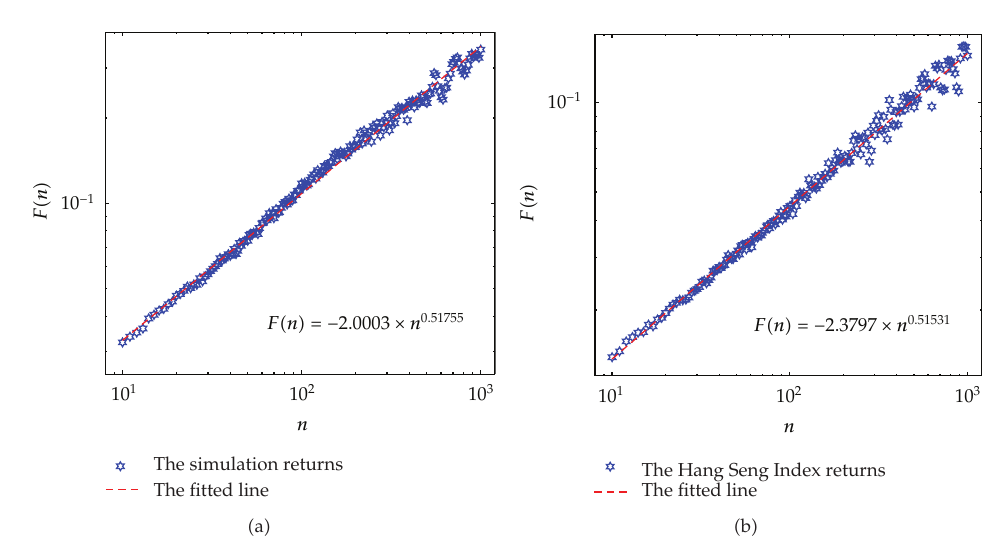
Figure 5: (cid:2) a (cid:5) DFA analysis of the returns for the simulation data with the intensity p (cid:6) 0 . 49. (cid:2) b (cid:5) DFA analysis of the returns for Hang Seng